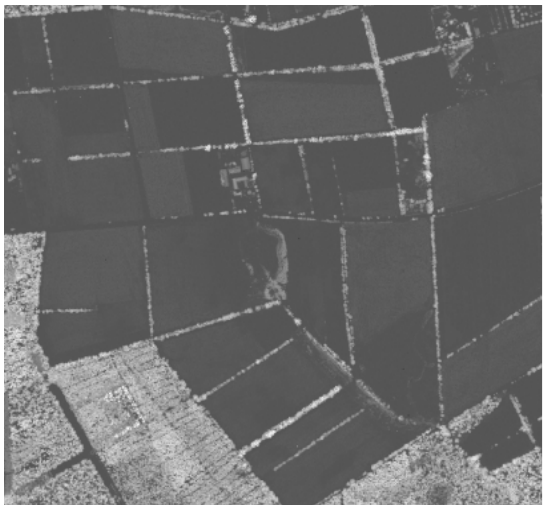
Figure 3. Example data from the LIDAR acquisition. This scene represents the same temporal and spatial location as depicted in Figure 2. Higher structures (mainly vegetation but also some houses) have lighter shades of